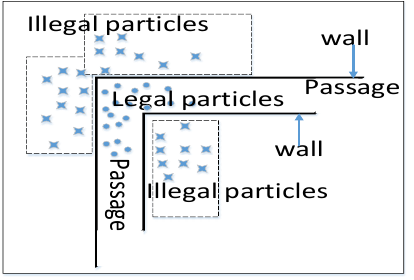
Figure 14. Diagram of particle constraints with the floor plan.